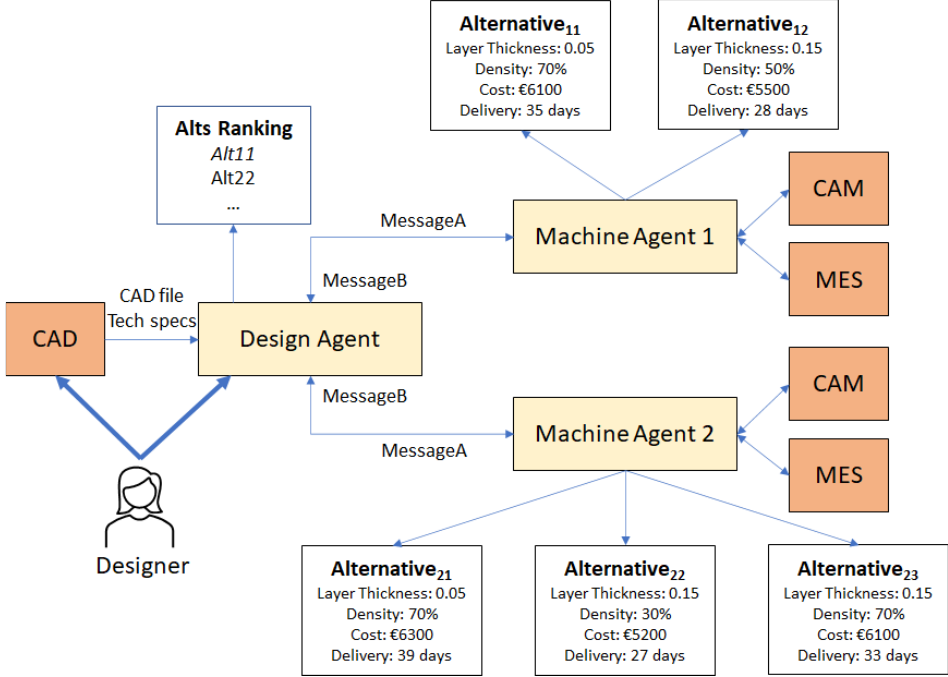
Figure 5. Example of the information exchange process.